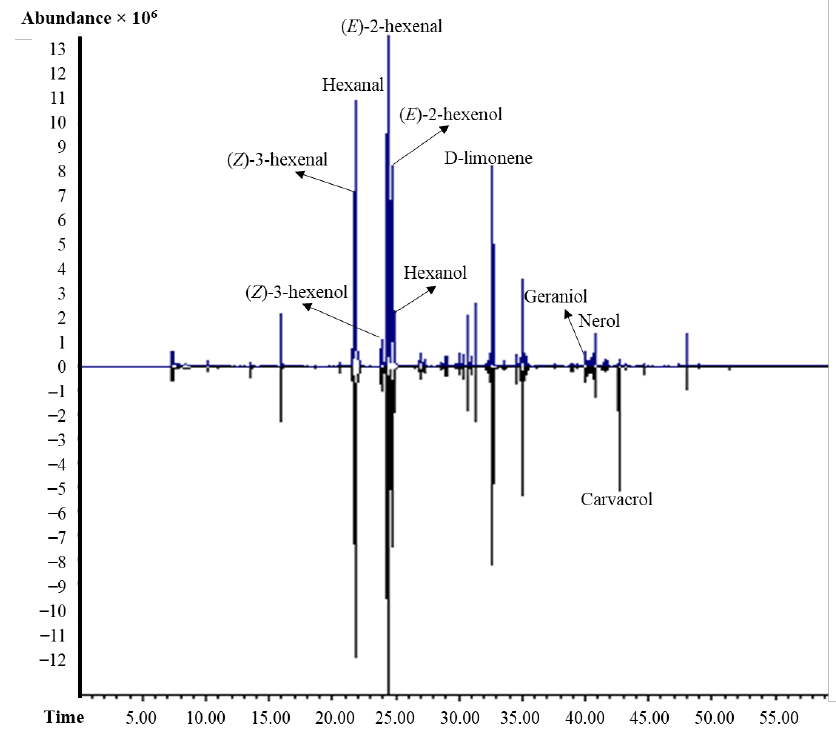
Figure 4. GCMS chromatograms of microencapsulated carvacrol (top) and non-encapsulated car- vacrol (bottom) treated blueberries after 7 days storage at 10 °C. Control blueberries had similar chromatograms with no carvacrol detected.